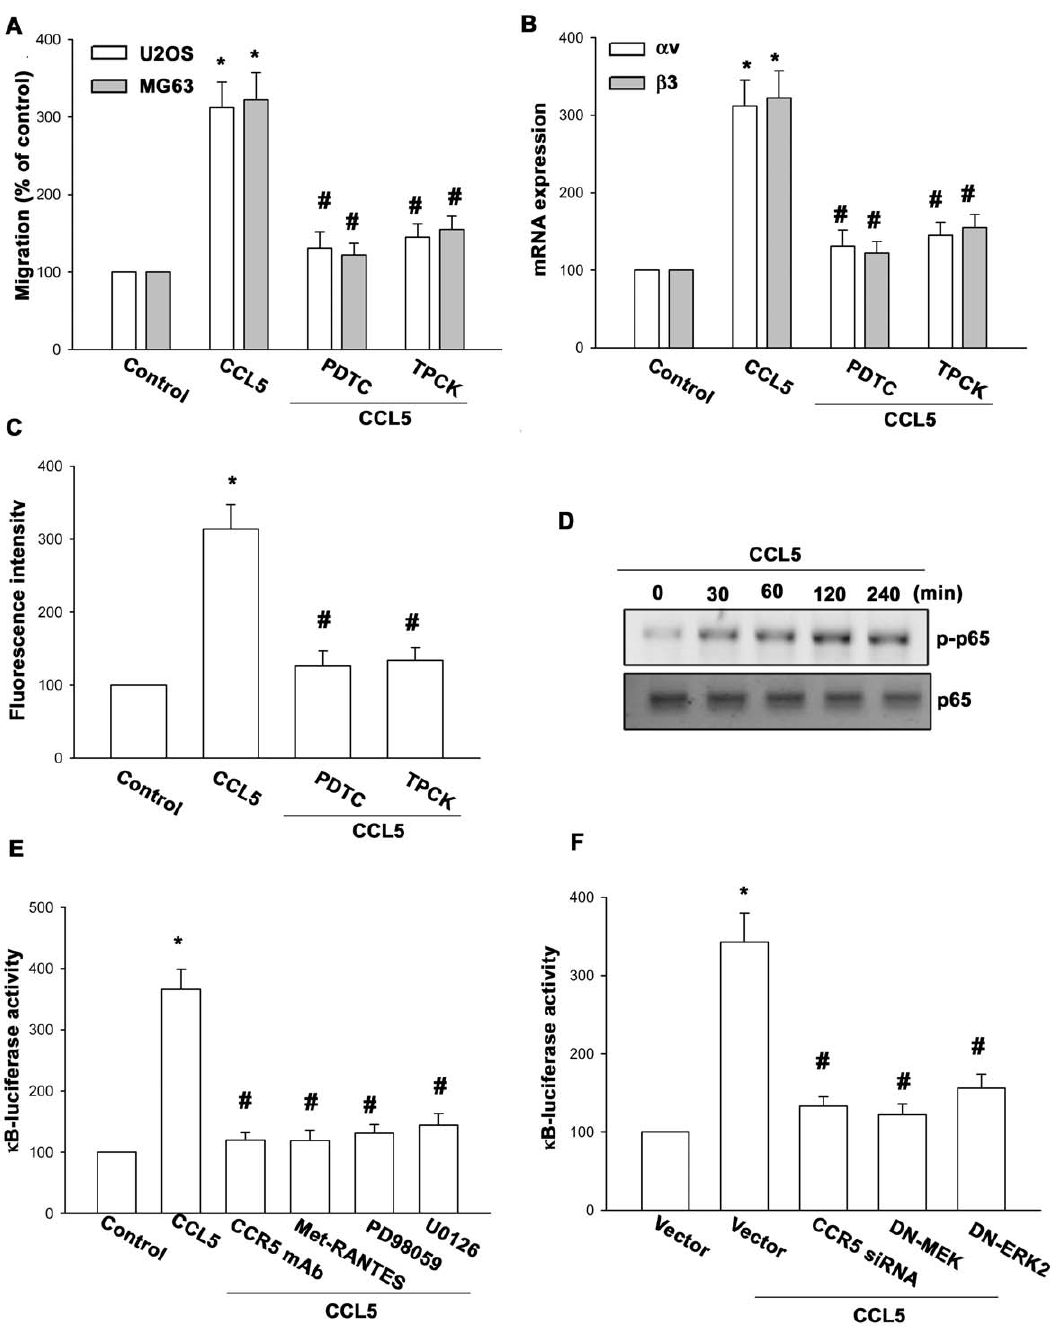
Figure 5. CCL5 induces cell migration and a v b 3 integrin expression through NF- k B. (A–C) MG63 or U20S cells were pretreated for 30 min with PDTC or TPCK followed by stimulation with CCL5. The in vitro migration and integrin expression was examined by Transwell, qPCR, and flow cytometry analysis. (D) MG63 cells were incubated with CCL5 for indicated time intervals, and p-p65 expression was determined by Western blotting. (E&F) MG63 cells were pretreated with CCR5 Ab, Met-RANTES, PD98059, and U0126 for 30 min or co-transfected with MEK1 and ERK2 mutant or CCR5 siRNA before exposure to CCL5. The NF- k B driven luciferase activity was measured, and the results were normalized to the b -galactosidase activity and expressed as the mean 6 S.E. for three independent experiments performed in triplicate. Results of five independent experiments performed are expressed. Results are expressed as the mean 6 S.E *, p , 0.05 compared with control; # , p , 0.05 compared with CCL5-treated group. doi:10.1371/journal.pone.0035101.g005 study, we found that both CCR5 and a v b 3 integrin receptor up- involved in CCL5-increaed cell migration and integrin expression. regulated after CCL5 stimulation. In addition, CCR5 Ab, Met- Whether other physical or functional connection between these RANTES, or CCR5 siRNA also blocked CCL5-incrased a v b 3 receptors is needs further examination. integrin expression. Therefore, CCR5 is upstream receptor